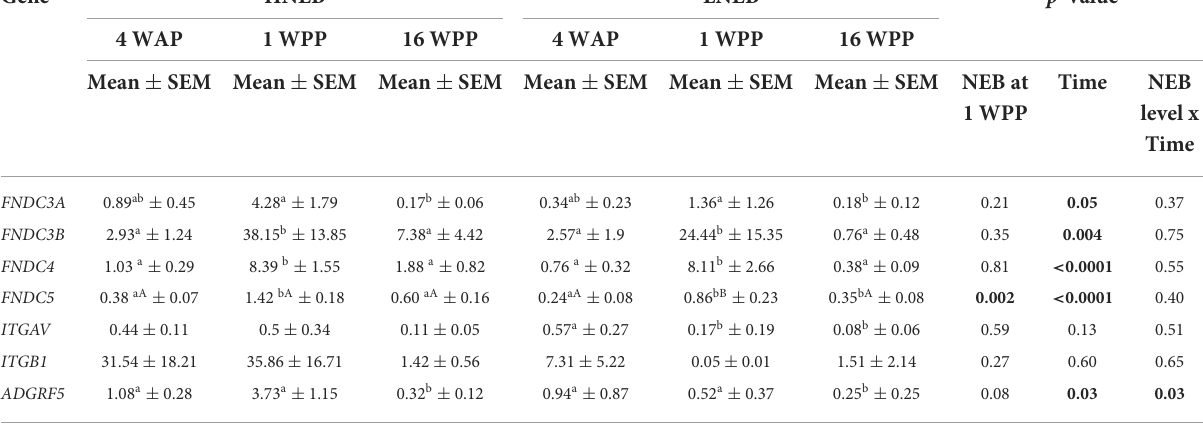
TABLE 7 Relative gene expression of FNDC3A, FNDC3B, FNDC4, FNDC5, ITGAV, ITGB1 and ADGRF5 in LNEB and HNEB animals during the peripartum period (1WAP, 1 and 16WPP) 1 . Gene HNEB LNEB p